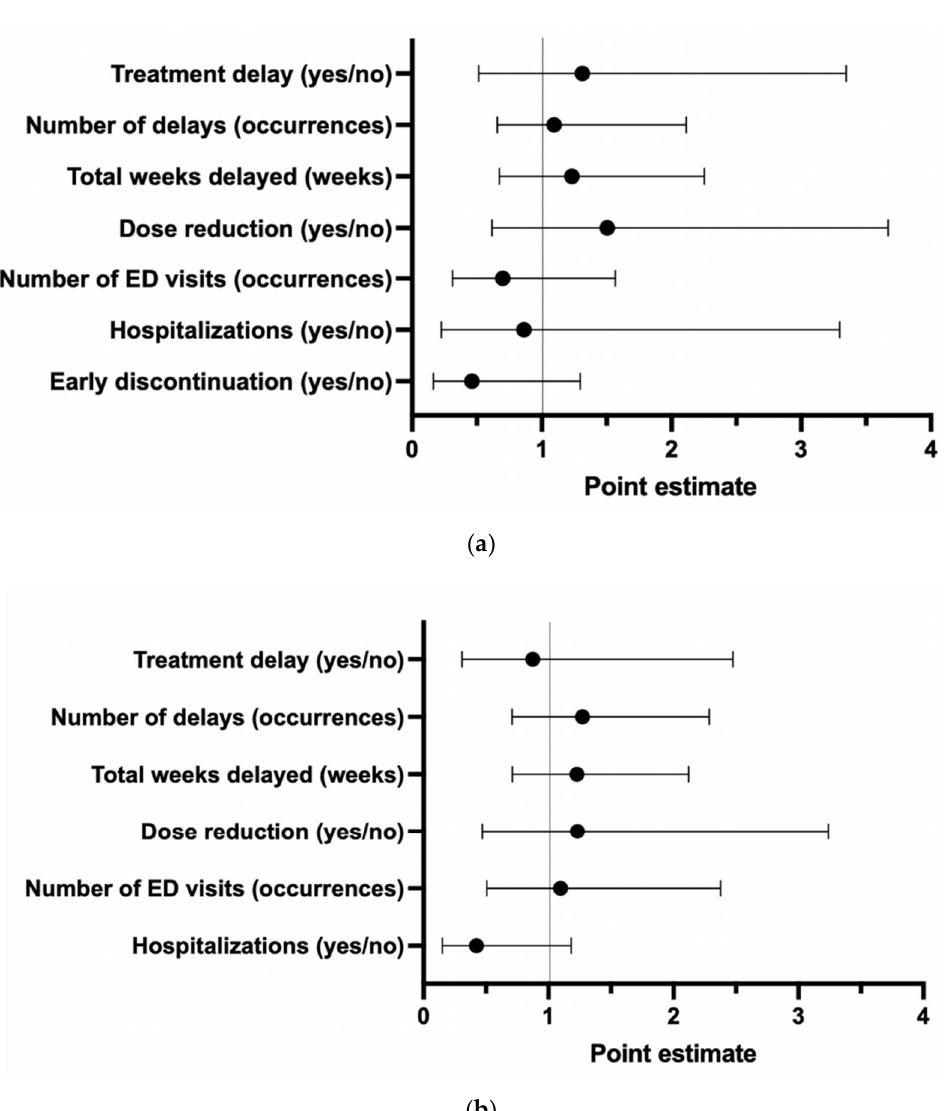
Figure 2. Subgroup analysis of patients with ( a ) nonmetastatic and ( b ) metastatic colorectal cancer represented as a Forest Plot of the point estimates and 95% confidence intervals for each outcome compared in the pre- versus intra-pandemic period, where a positive estimate indicates that the outcome is more likely in the intra-pandemic period. Models adjusted for age, chemotherapy type, modified Charlson comorbidity index, and number of cycles received.